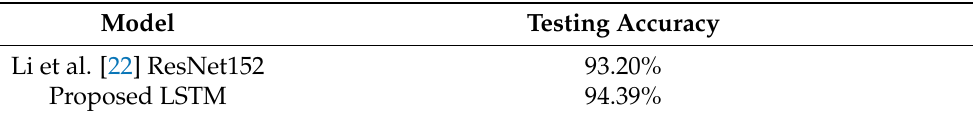
Table 6. Testing Accuracies: testing performance of the proposed method with the state-of-the-art method by Li et al. [22] on the custom dataset. Li et al. [22] used VGG16, ResNet50, ResNet101, and ResNet152 CNN models for analysis. We trained the ResNet152 network using the facial landmarks and compared it with the proposed best-performing LSMT